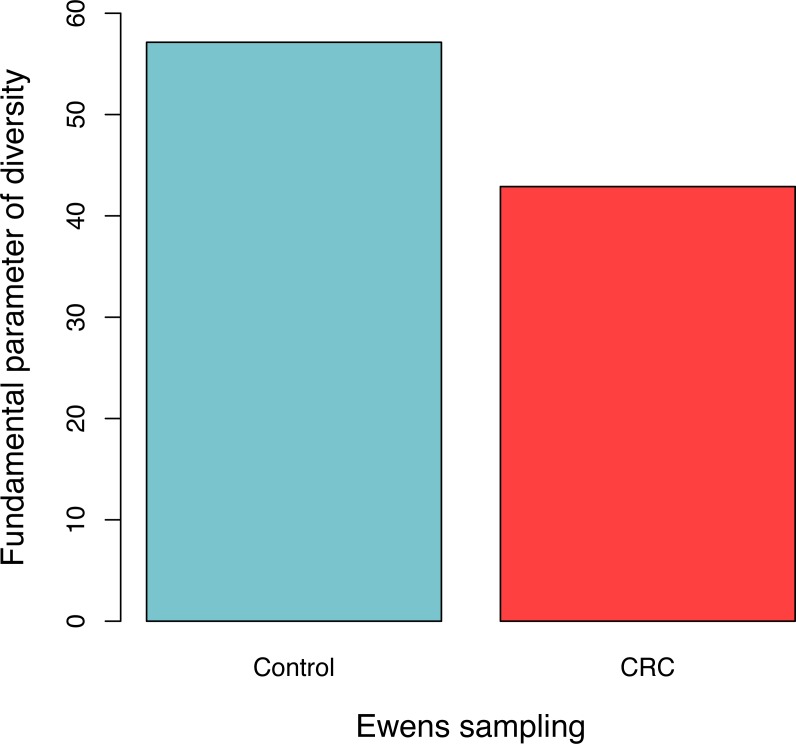
The average fundamental diversity parameter (θ) in the control (healthy individuals) and CRC (patients), respectively.There is significant difference between both the groups based on Student’s t-test (p < 0.01)